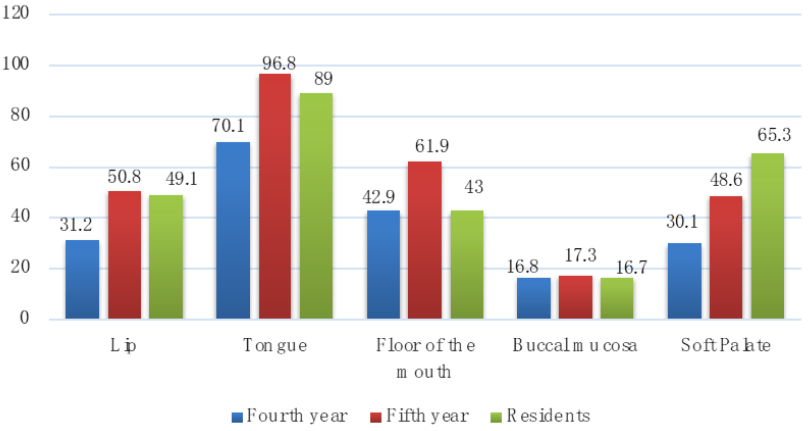
Figure 2. Percentage of participants that correctly identified most common sites for oral cancer (Q3).